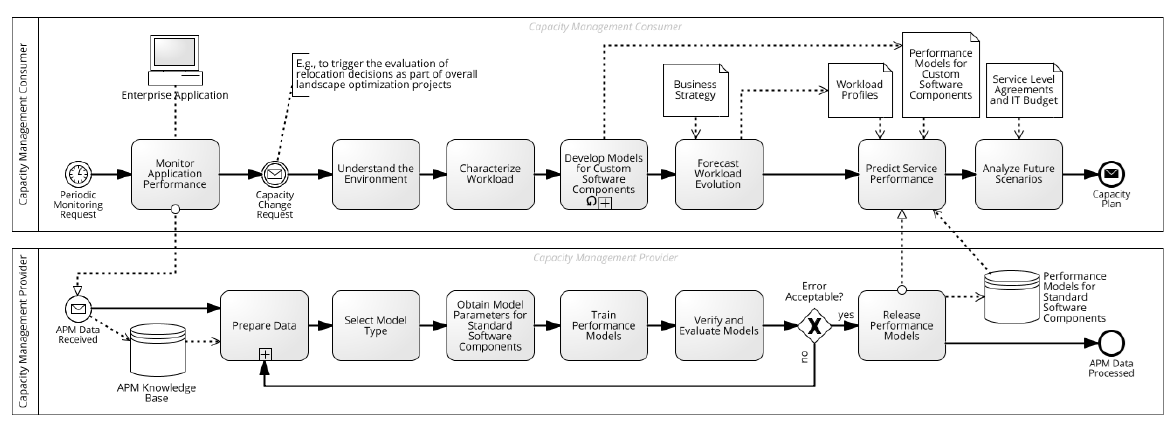
Figure 2. Capacity management process model for enterprise standard